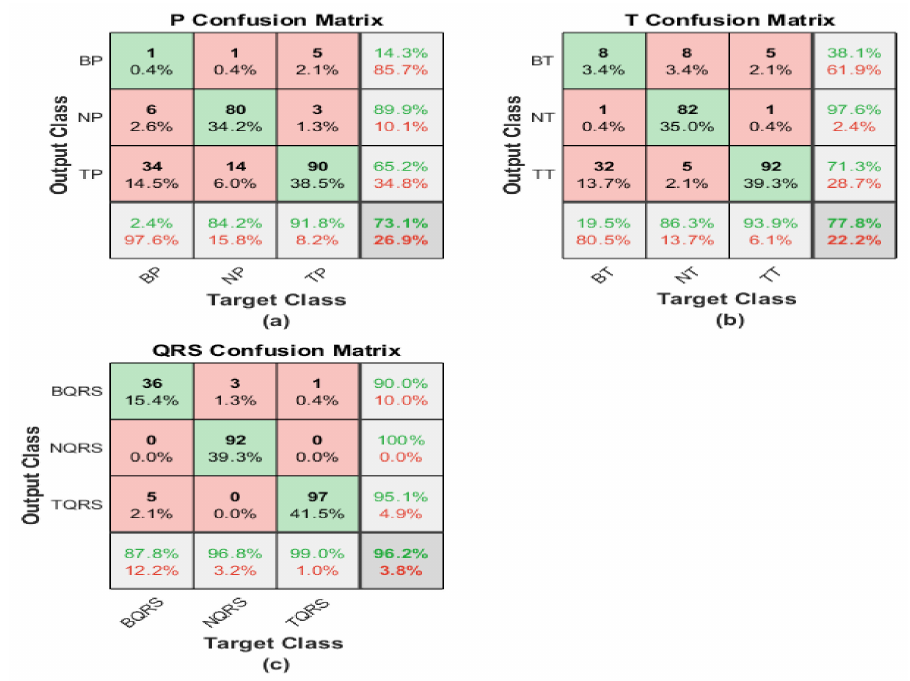
Figure 12. Confusion matrices of ECG SGs using ResNet101: ( a ) P-waves SG; ( b ) T-waves SG; ( c ) QRS-waves